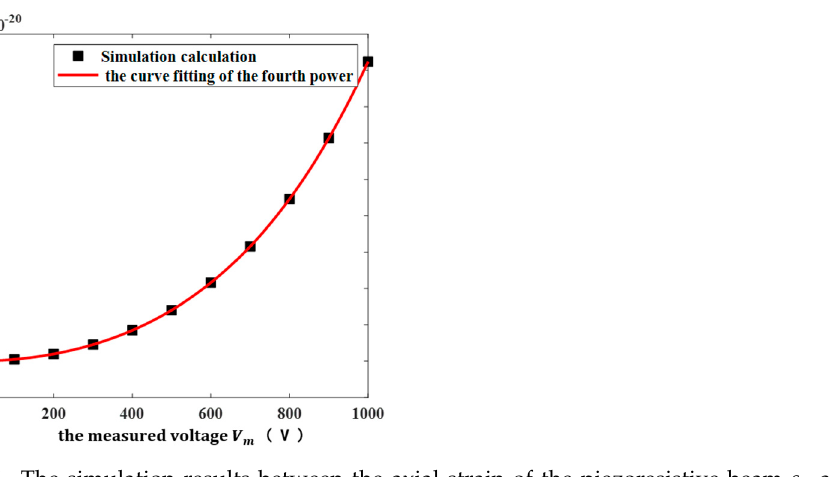
Figure 5. The simulation results between the axial strain of the piezoresistive beam ε x and the amplitude of the measured voltage V m .